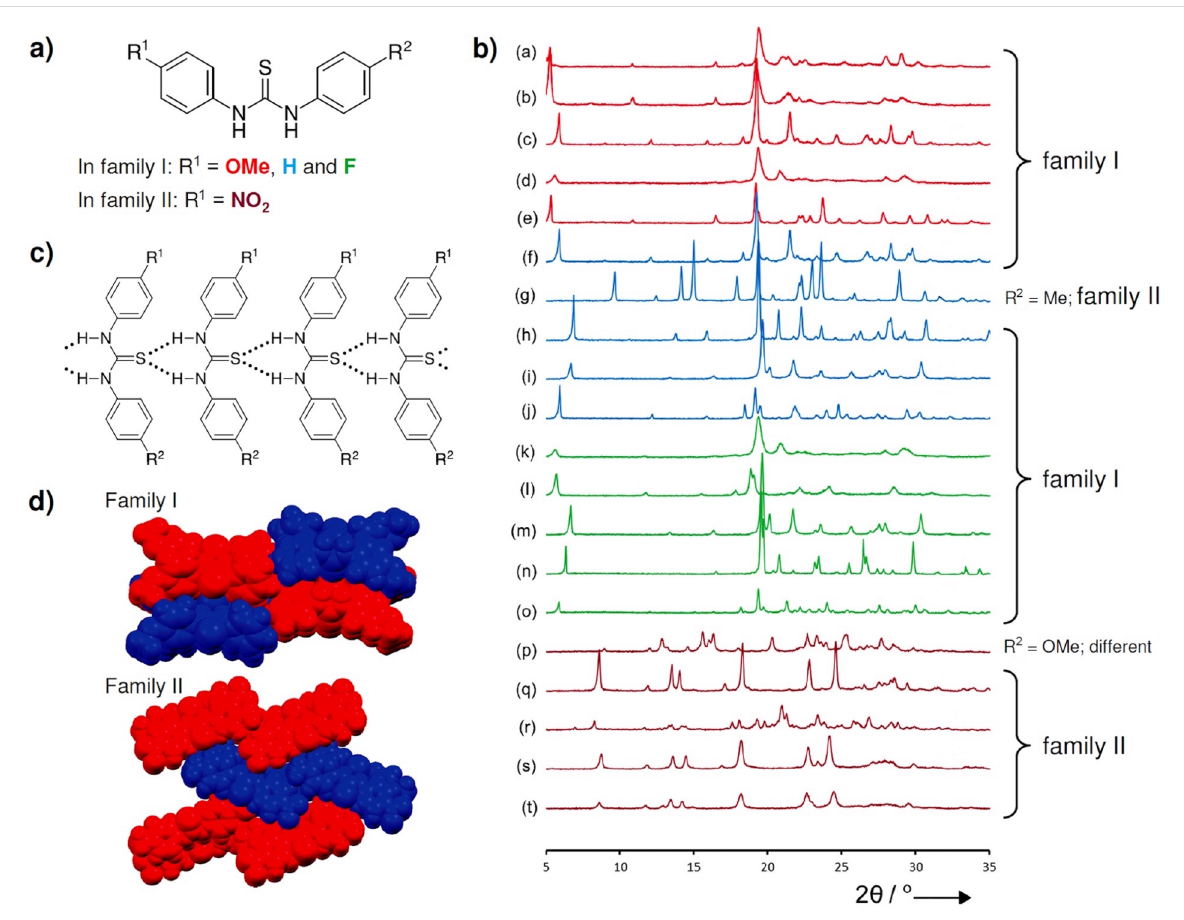
Figure 3: The supramolecular level of organization of thioureas in the solid-state.